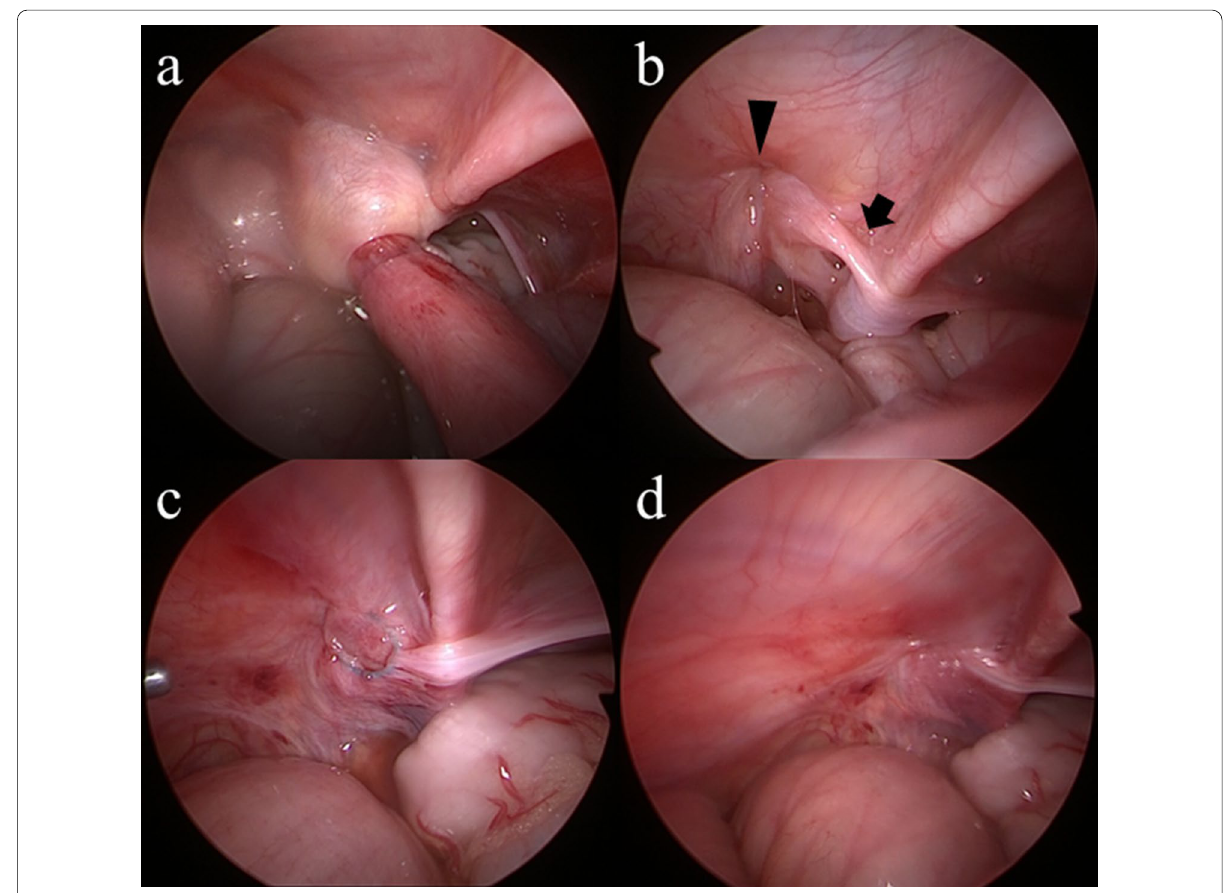
Fig. 4 Operative findings. a Small bowel dilatation and a loop of small intestine remained trapped in the hernia with a thickened peritoneum at the neck of the sac in the left inguinal. b The hernia sac(black arrow) was not associated with the processus vaginalis(black arrowhead), which had been closed by a previous open procedure. c The hernia neck was encircled without skipping. d The hernia neck received high